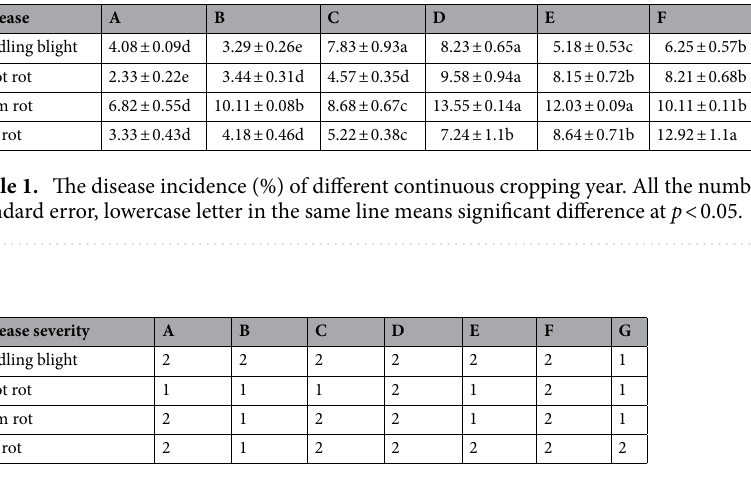
Table 2. The severity of different disease in different continuous cropping year. 1 means level one, 2 means level two, 0 means no disease